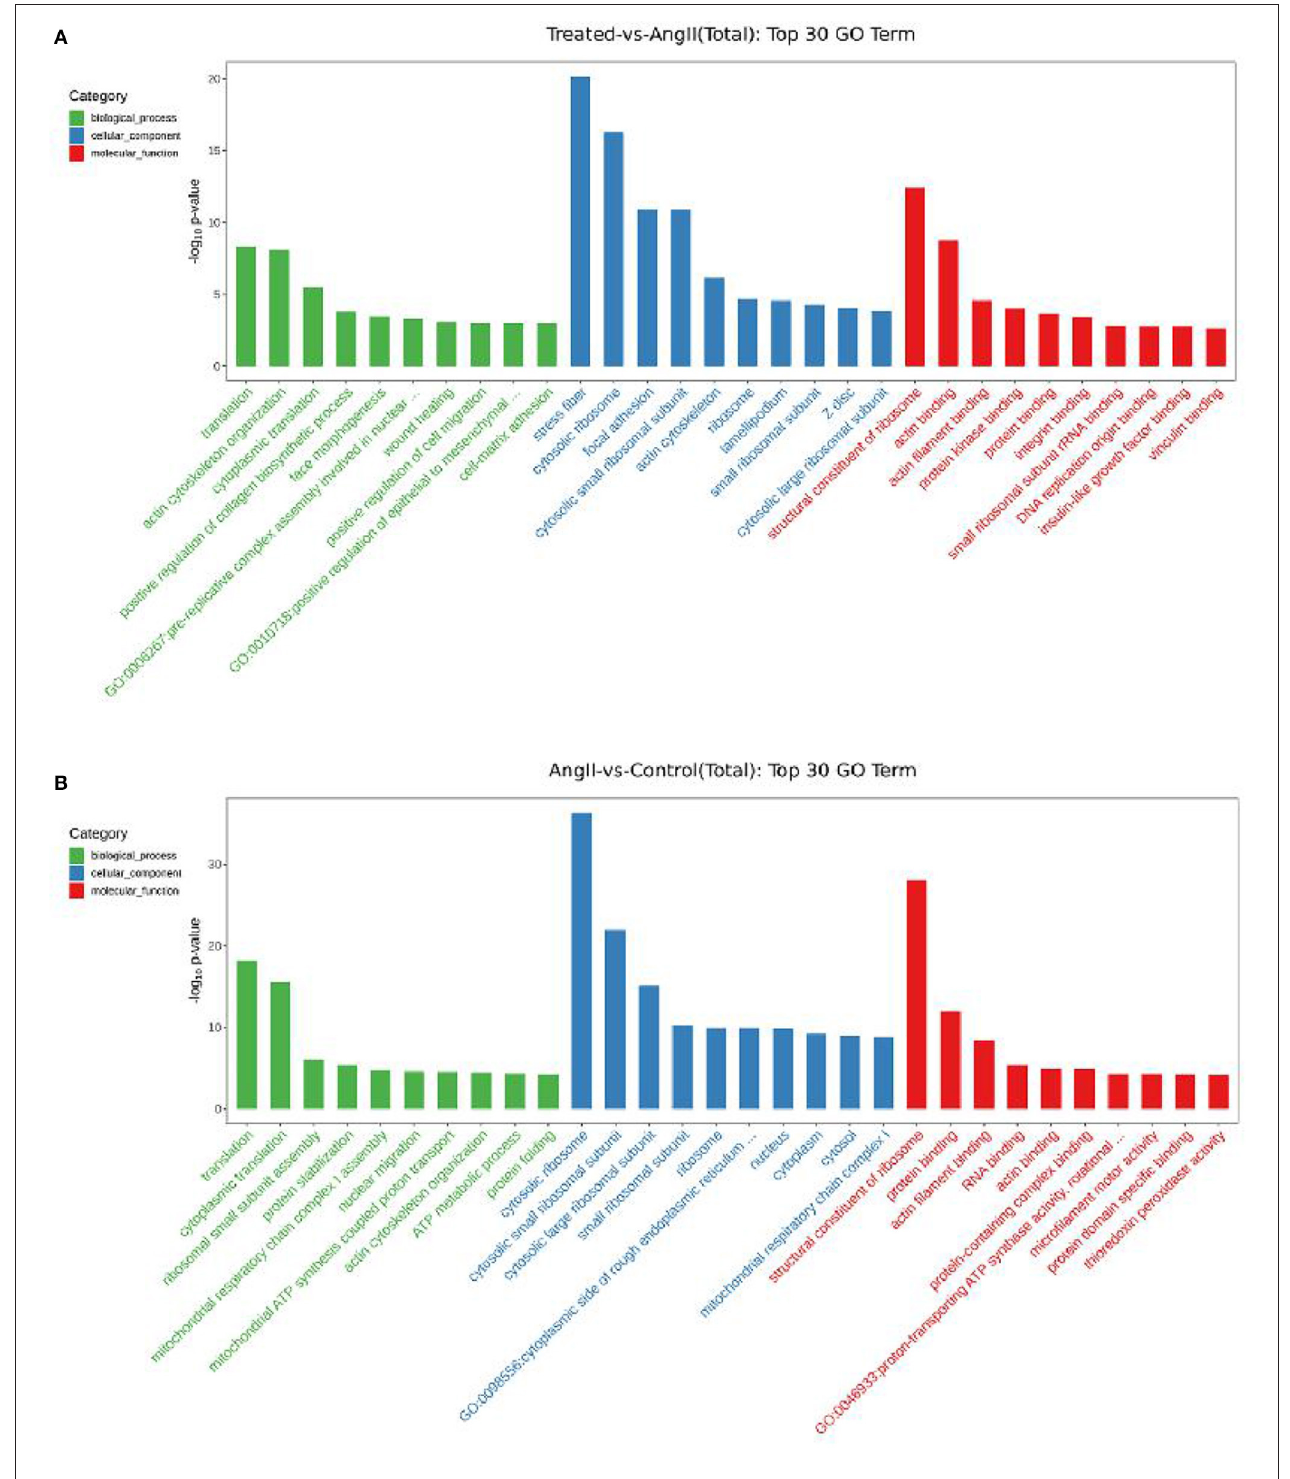
FIGURE 7 | Gene Ontology (GO) enrichment analysis for differentially expressed genes (DEGs). (A) Top 30 GO-terms of DEGs in FPQYLQYPY treated group and Ang II-treated group. (B) Top 30 GO-terms of DEGs in the Ang II-treated group and control group.